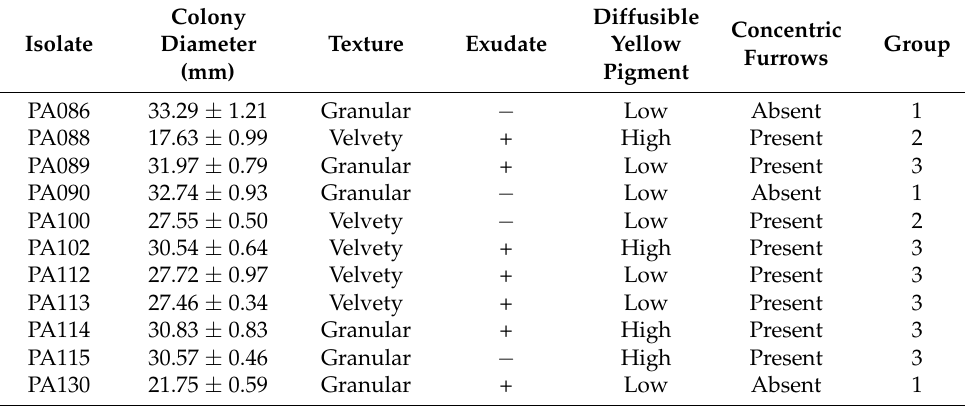
Table 3. Morphological characteristics of the fungal colonies of P. allii on CYA medium after 7 days at 25 ◦ C and their classification into different groups. The mean diameter of the mycelial colony ± standard deviation is